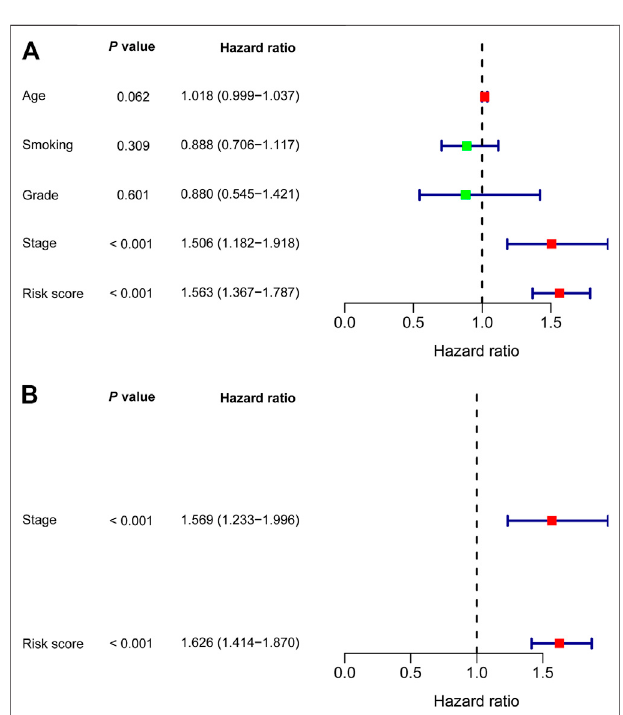
FIGURE 4 | Nomogram was developed based on (A) Univariate and (B) multivariate Cox regression analysis.